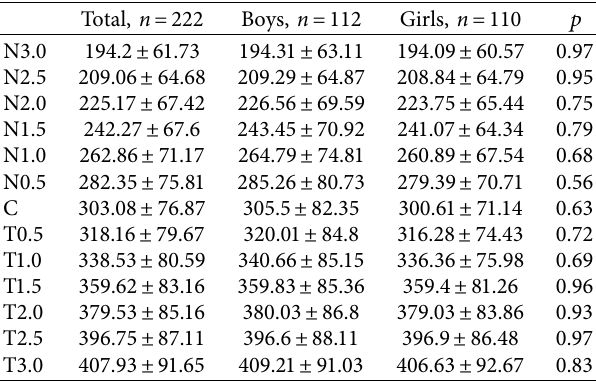
Data are shown as mean ± standard deviation; p -values in boldface text indicate statistical significance. Table 2: Mean choroidal thickness of all patients, Mean ± SD, μ